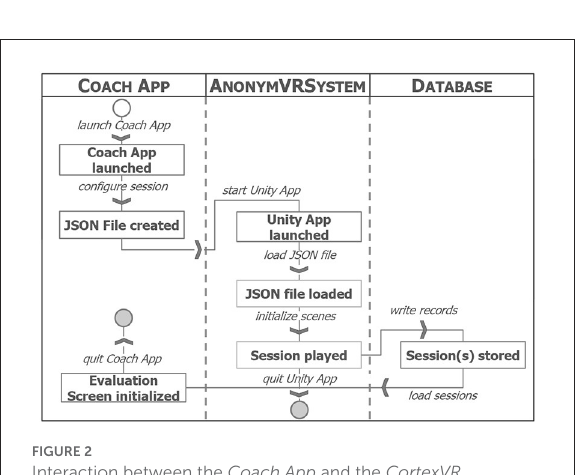
FIGURE2 Interaction between the Coach App and the CortexVR